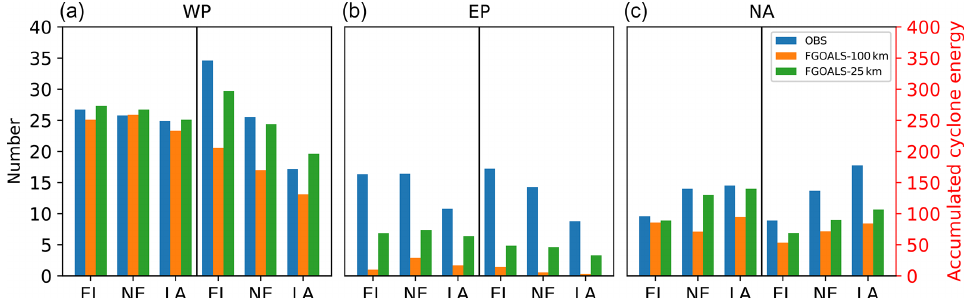
Figure 10. Bar chart showing the average number of tropical cyclones (left-hand panels) and ACE (right-hand panels) from El Niño (EL), neutral (NE) and La Niña (LA) years in the (a) western Pacific (WP), (b) eastern Pacific (EP) and (c) northern Atlantic (NA) oceans.